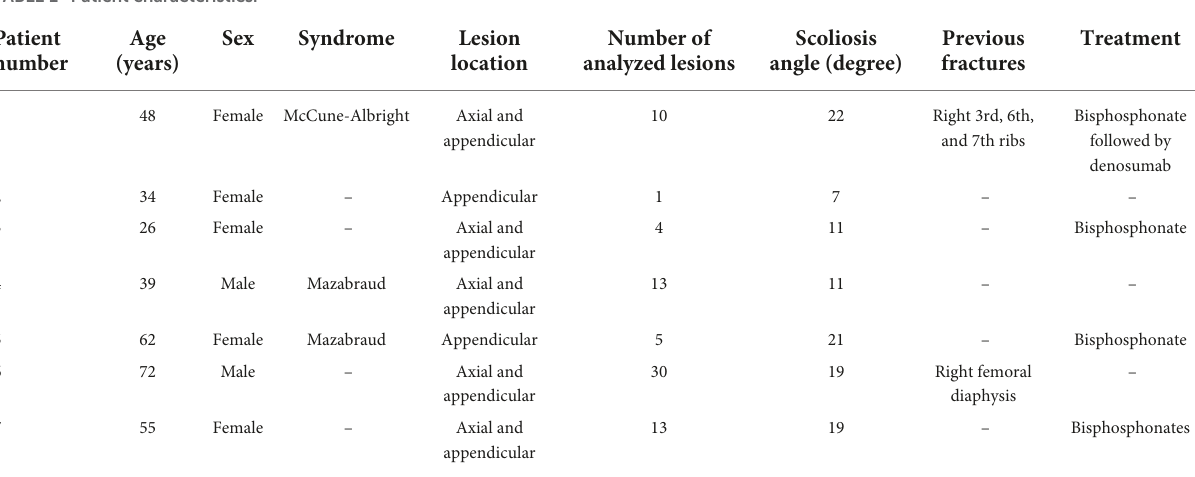
TABLE 1 Patient